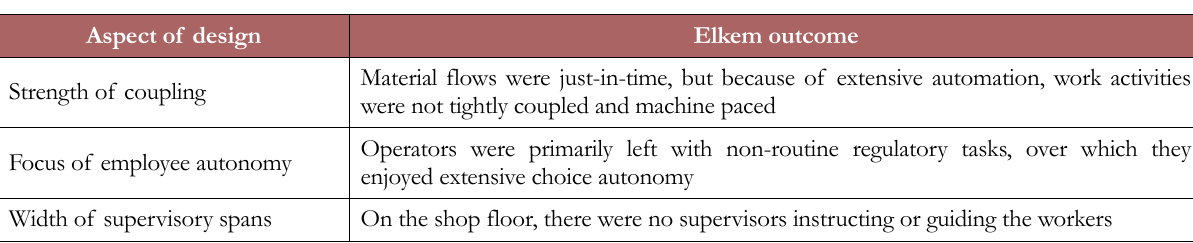
Table 3. Elkem’s shop-floor organization with respect to design